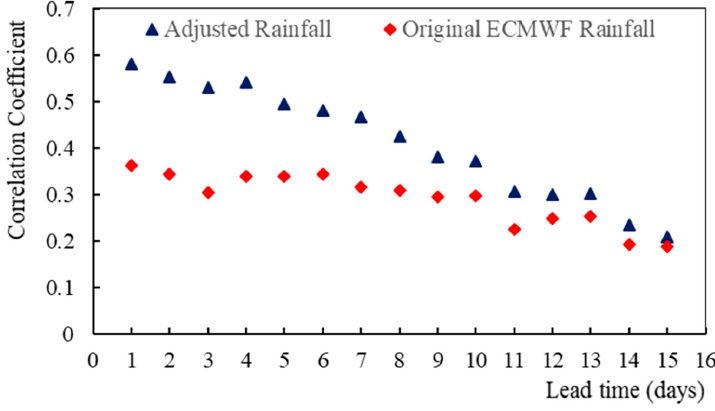
Figure 6. Predictive skill of S2S ECMWF precipitation and the corrected precipitation in the validation period as function of forecast lead time.